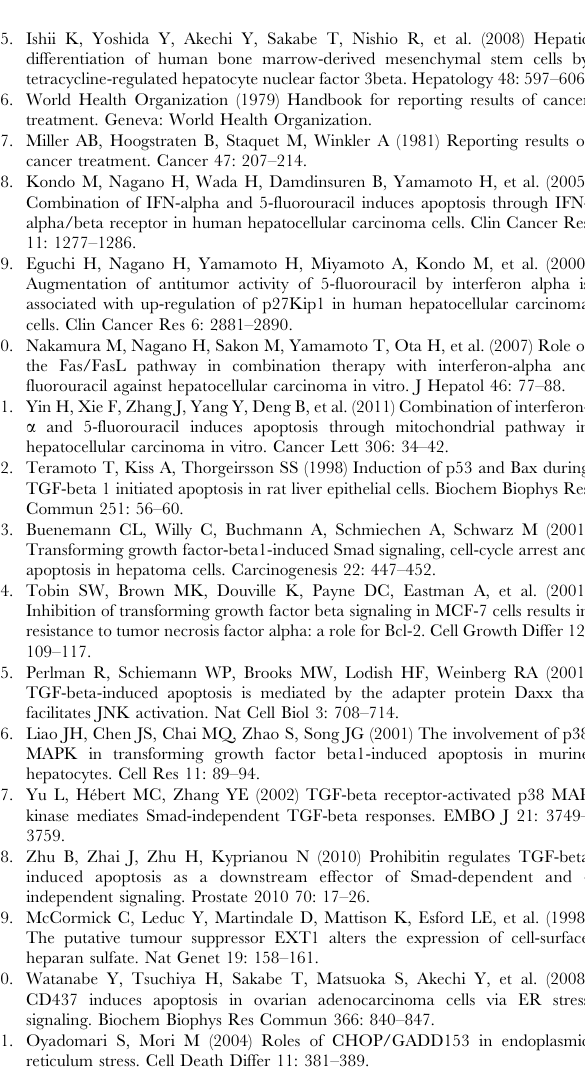
Table S1 Primers used in the experiments. All used in this study were obtained in purified form. Rz1 - Rz6 were used for the construction of random ribozyme library as described in Figure S1. N indicates any nucleotide (A, G, C and T). PRKAG2 Bam HI - attB2 reverse were used for the construction of adenovirus plasmid DNA carrying PRKAG2, TGFBR2 and EXT1. Table S2 Results of BLAST search of original ribozyme library and plasmid DNAs recovered after ten cycles of screening. The ribozyme target recognition sequences recovered